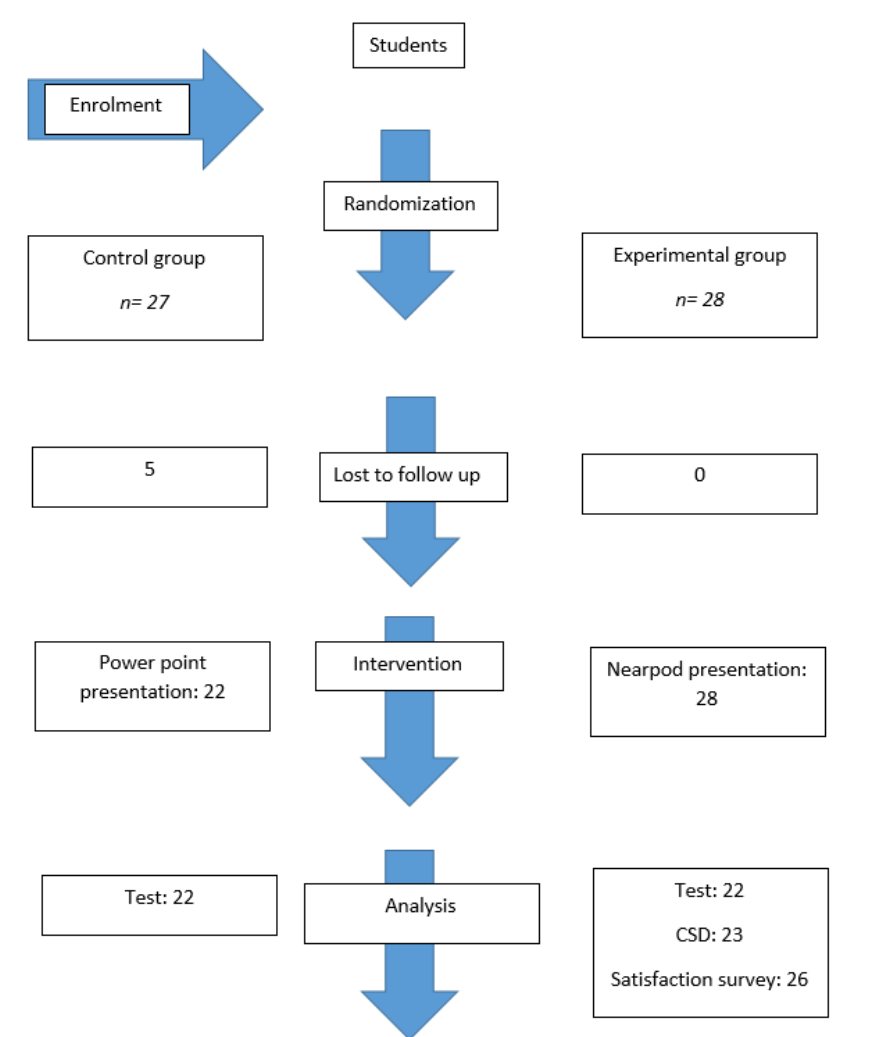
Figure 1. Flow diagram of student allocation.